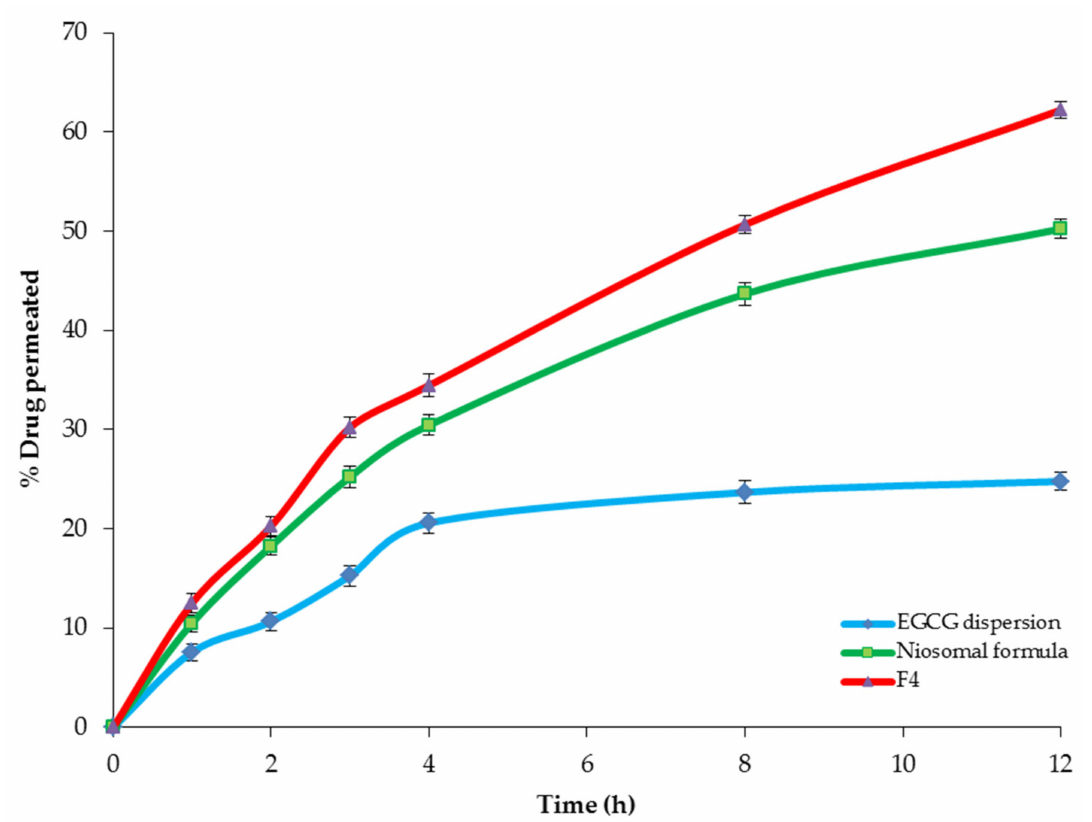
Figure 10. The ex vivo permeation profile of F4, the conventional niosomes, and EGCG dispersion for 12 h. Abbreviation: EGCG, epigallocatechin gallate..